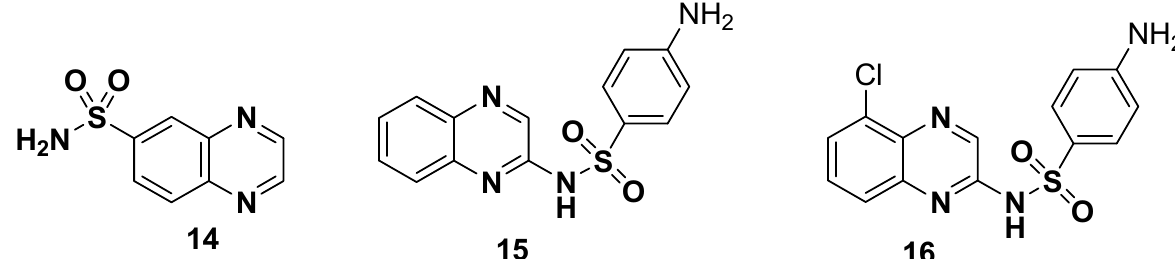
Figure 3. Structures of sulfonamide drugs 8 – 13 .